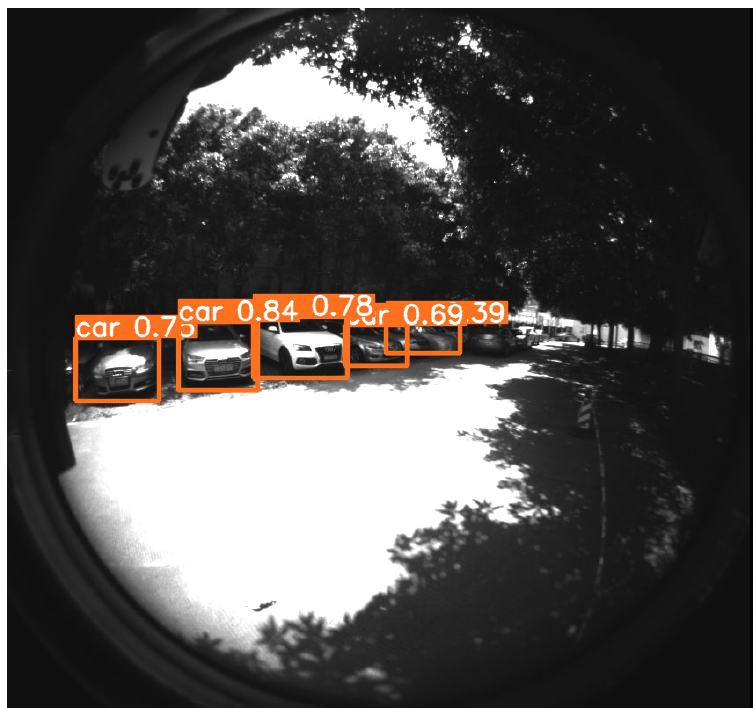
Figure 12. The intelligent car-detection